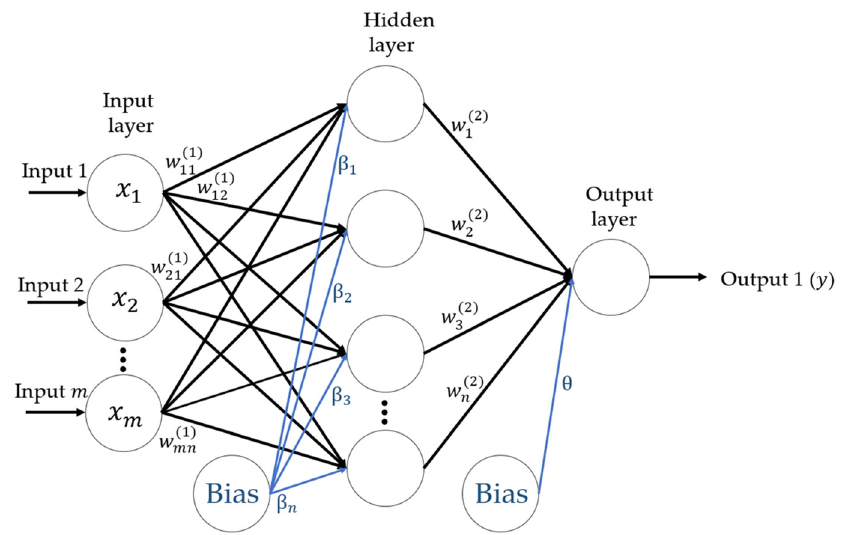
Figure 1. Single Hidden Layer Feed-forward ANN structure [32].